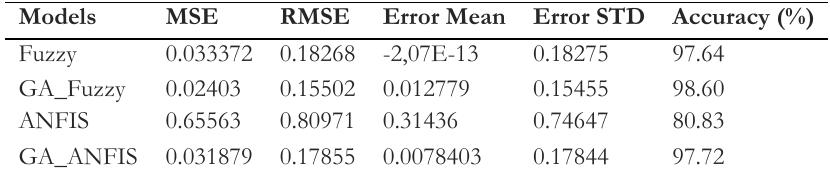
Table 3. Performance indices for proposed GFS model.